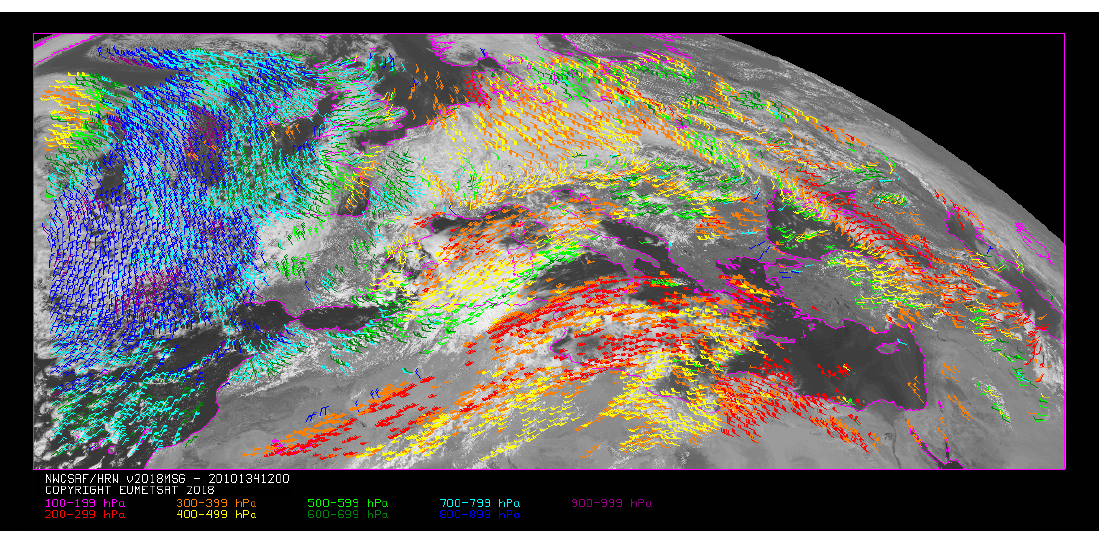
Figure 13. NWC/GEO-HRW v2018.1 AMV output example in the European and Mediterranean region considering the default conditions for processing (14 May 2010, 12:00 UTC, MSG-2 satellite). Color coding based on the AMV pressure. Table 4. Validation for NWC/GEO-HRW v2018.1 AMVs against radiosonde winds, considering all AMVs together and in three separate layers: high levels: 100–400 hPa; medium levels: 400–700 hPa; low levels: 700–1000 hPa (Jul 2009–Jun 2010, 12:00 UTC, MSG-2 satellite, European and Mediterranean